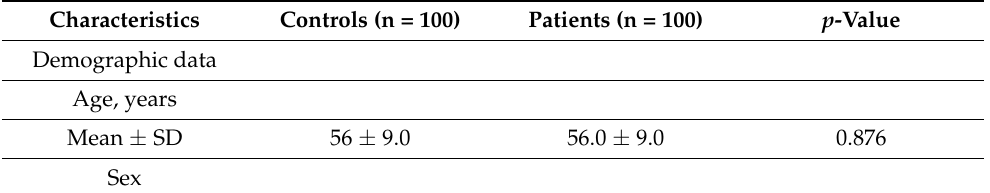
Table 1. Baseline characteristics of the study